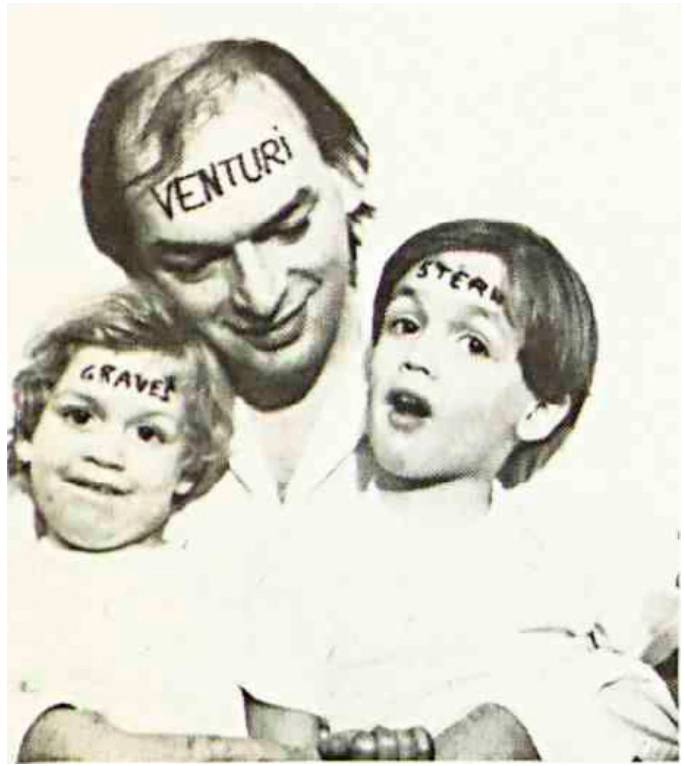
Figure 3. Image from the following article: Jean Nouvel, “Fragments: en differe ... interview: en directs”, in L 'Architecture d'aujourd'hui, 231 (Nouvel 1984), 10.